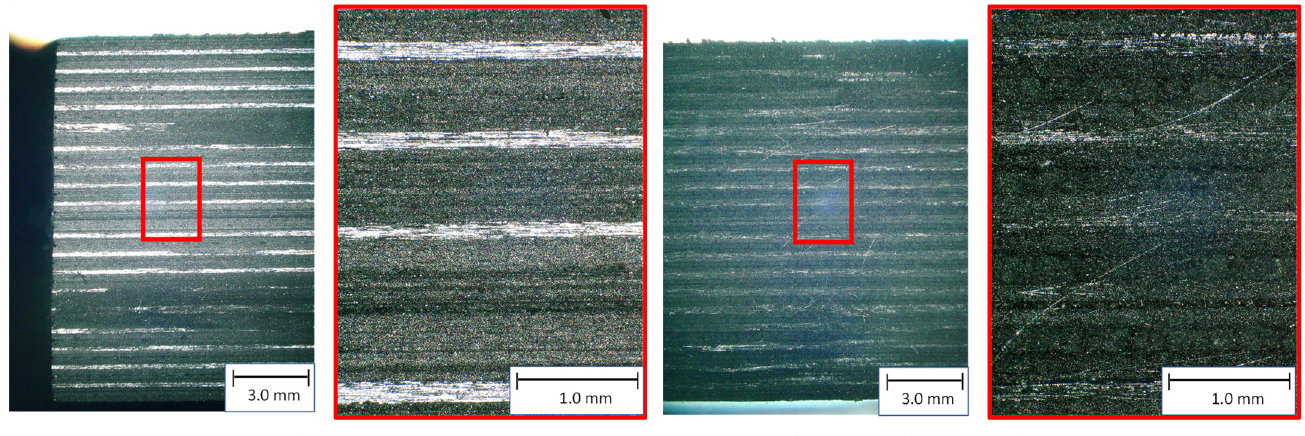
Figure 17. Grinding wheel after machining.